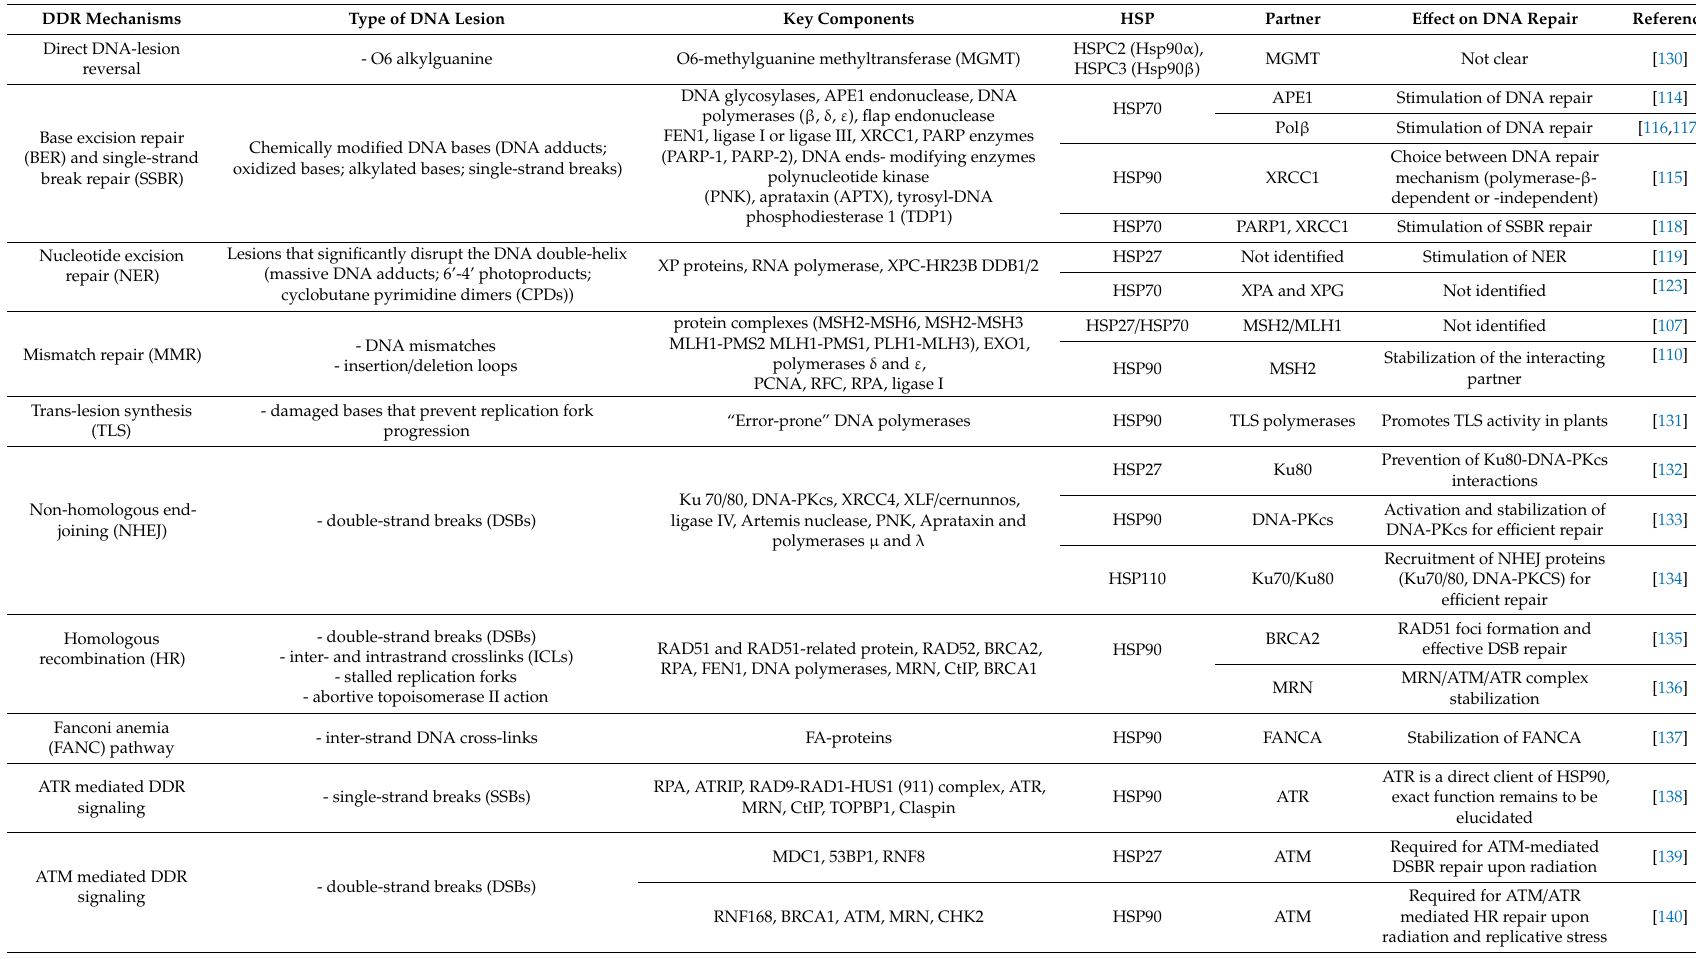
Table 1. The role of HSPs in eukaryotic DDR mechanisms. The key DNA repair components were provided with types of lesions repaired during DDR [2,100] with